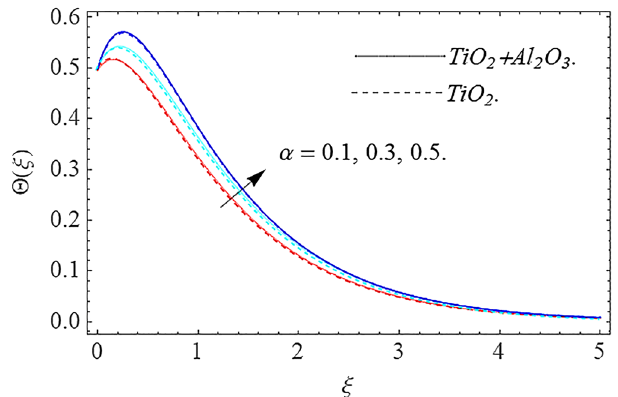
Figure 11. Thermal profile �(ξ) against α .